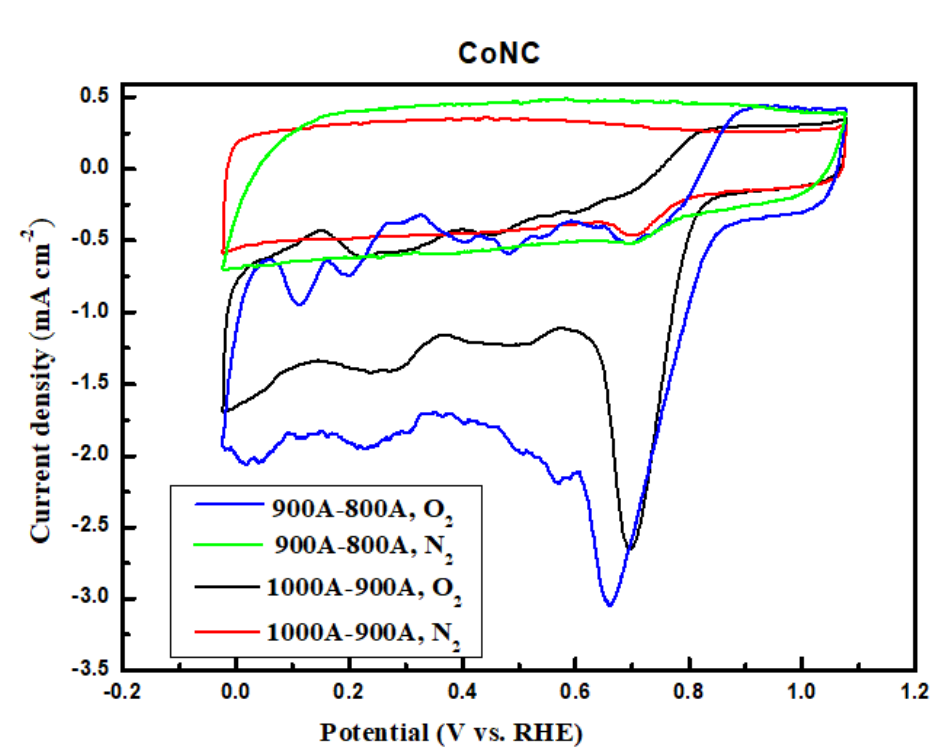
Figure 7. Polarization curves of CoNC 1000A-900A and 900A-800A in N 2 and O 2 atmospheres. To further examine the ORR capability of the Co-N-C catalysts, the electrode was replaced by a rotating disk electrode (RDE), and the LSV curves of Pt/C and Co-N-C catalysts were recorded in O 2 -saturated 0.1 M KOH(aq) (or 0.1 M HClO4 (aq) for com- parison) solution at 5 mV s − 1 and 1600 rpm. The reduction current density from 0 to 1